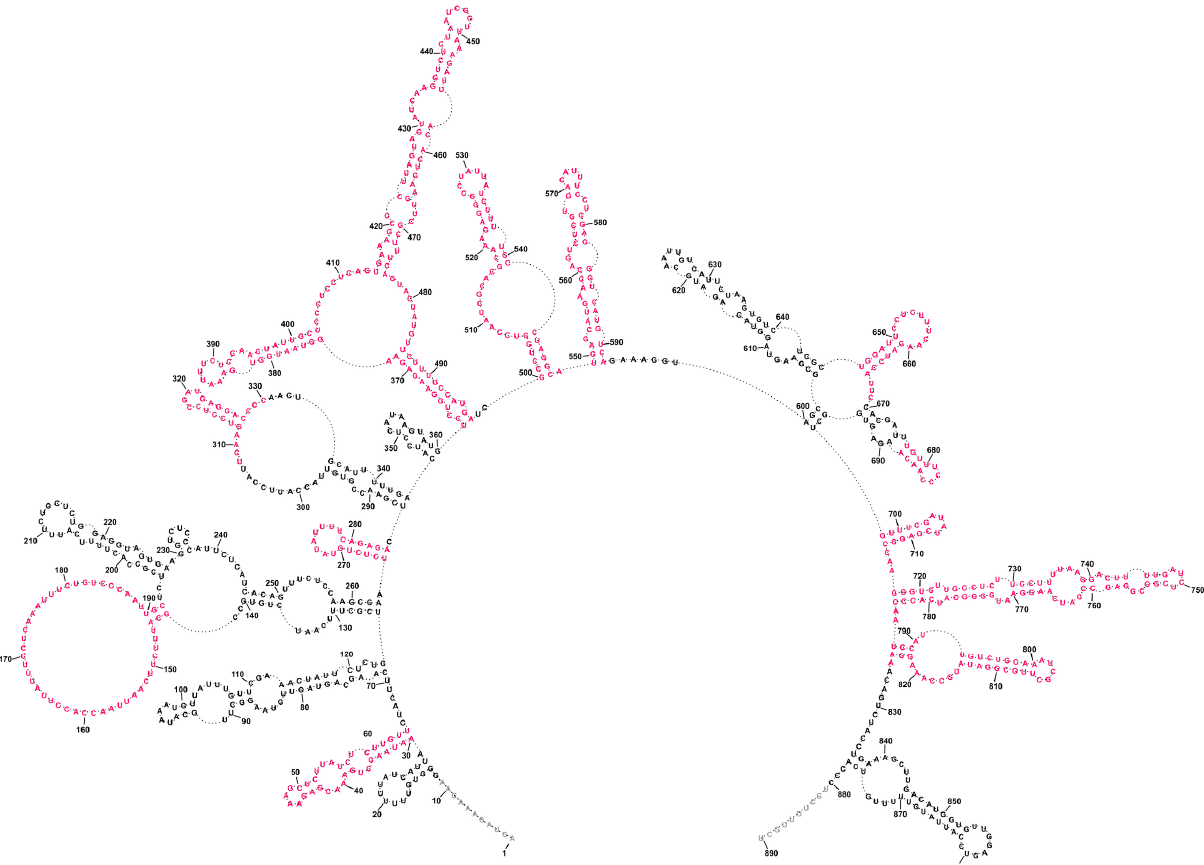
Figure 3. Local folding of vRNA8 A/California/04/2009 as predicted by RNAstructure using a maximum pairing distance. The structure was predicted by applying a maximum pairing distance of 150 nucleotides, with constraints from chemical probing with DMS and 1M7 (SHAPE) in cell lysates. This structure shows the preservation of 12 hairpins and a long loop region (red color) also predicted in the global structure without a distance restriction on base pairing (Figure 2).